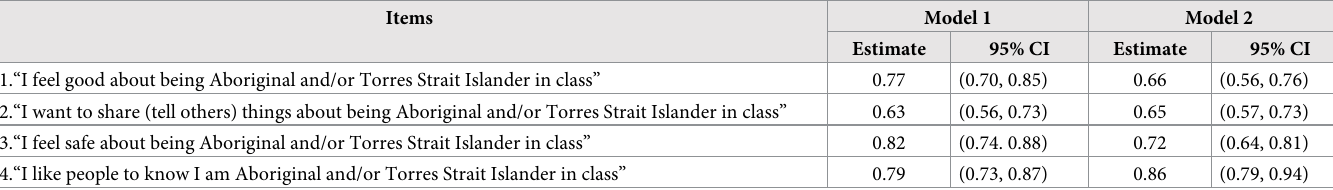
Table 2. Item loading estimates of the two unidimensional models of ERI affirmation.